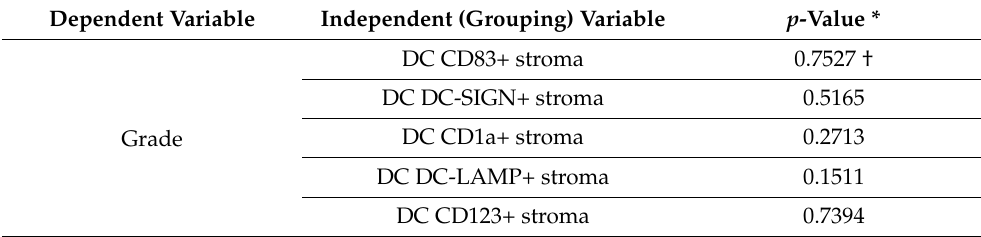
Table 4. Associations between counts of different DC subtypes and clinicopathological features of en- dometrioid cancers (ECs). For every IHC staining, samples of ECs were assigned to four groups based on the Q1, Me, and Q3 value of the positively identified DC numbers. The table shows differences in the cancer’s grade and stage (pT and pN) between mentioned groups. The statistics were